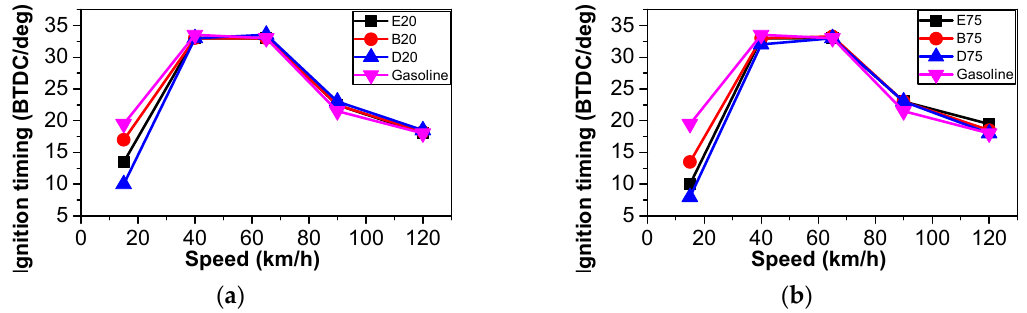
Figure 3. Comparison of ignition timing of different fuels at different blending ratios: ( a ) 20% blending ratio; ( b ) 75% blending ratio.